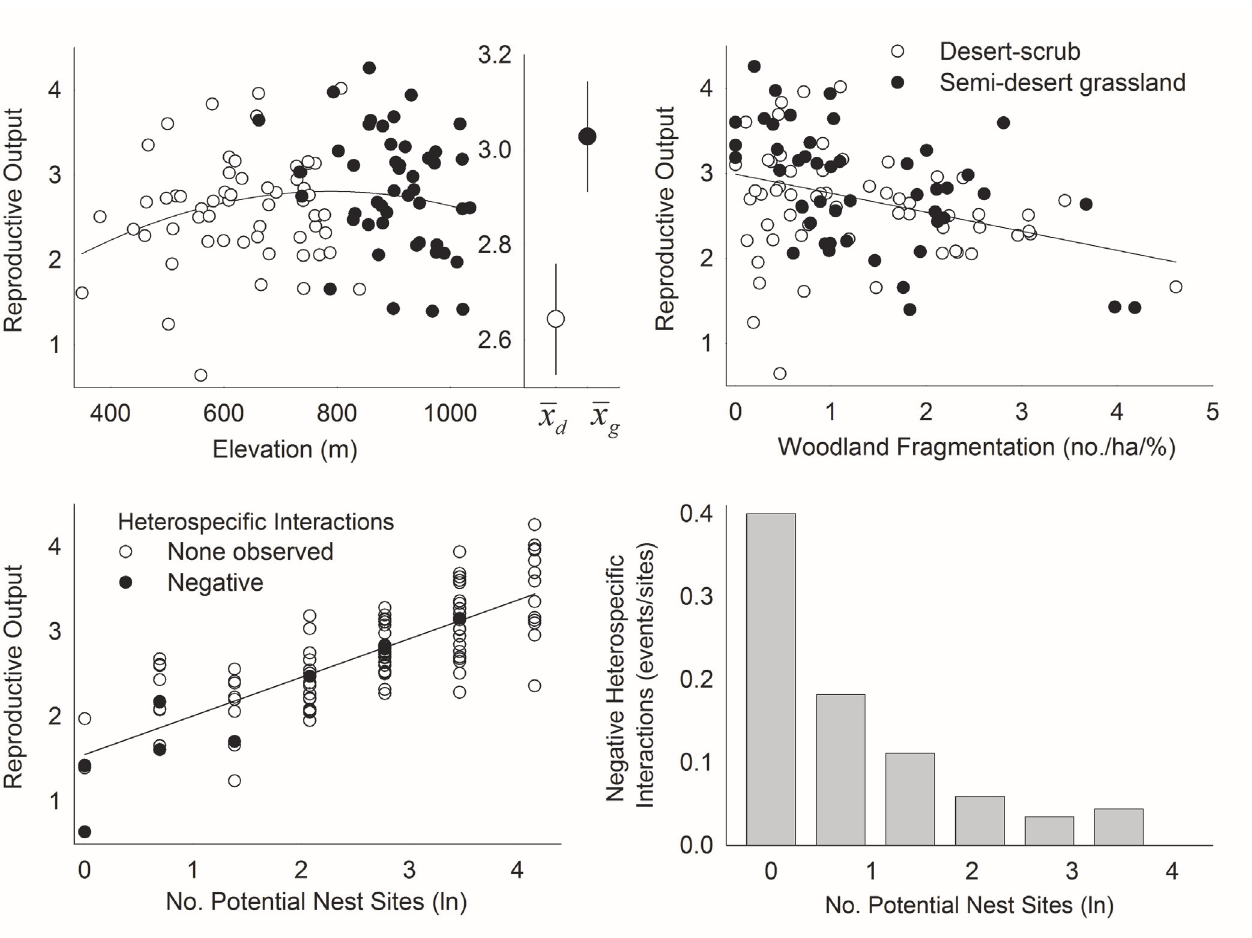
Fig 2. Interactive effects of abundance of potential nest sites and other habitat factors on reproductive output of ferruginous pygmy-owls in northwest Mexico, 2001 – 2010. Estimates of reproductive output are based on the top-ranked models that include each of the habitat factors represented as summarized in Table